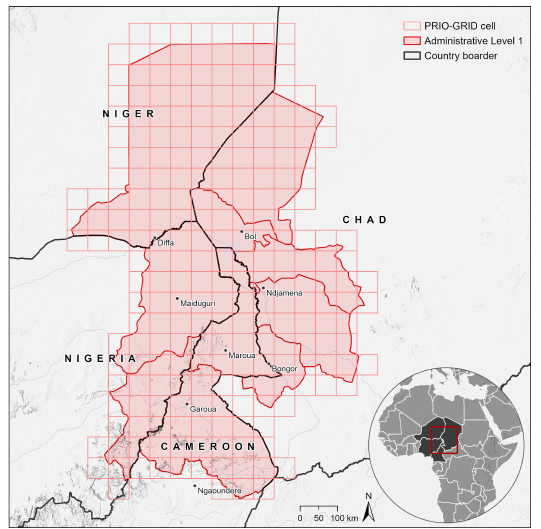
Figure 1. Study Area (data source: Global Administrative Areas, 2012, Tollefsen et al., 2012,OpenStreetMap contributors, 2022; Service Layer Credits: Airbus,USGS,NGA,NASA,CGIAR, NCEAS,NLS,OS,NMA,Geodatastyrelsen,GSA,GSI and the GIS User Community;